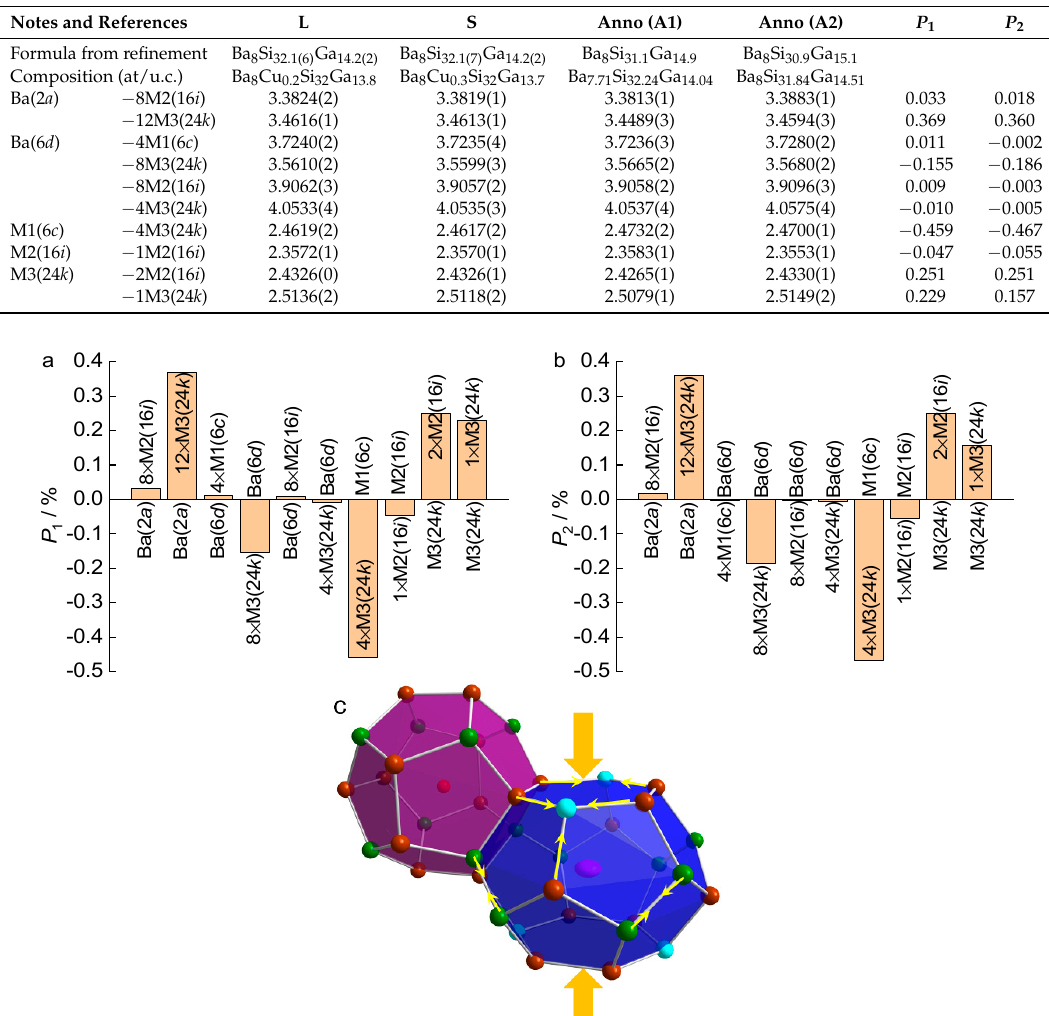
Figure 7. Interatomic distance changes (percentages P i , definition see Table 2) caused by Cu substitution ( a ) P 1 , ( b ) P 2 , and ( c ) a sketch shows the changes in the large